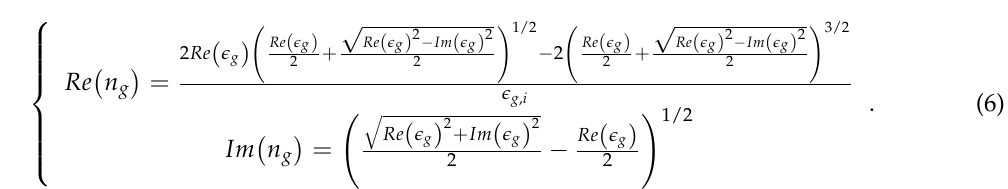
Figure 1c maps the numerically calculated results of the complex permittivity and complex refractive index. These results directly indicate the optical dispersion of graphene-based microfiber structures, which was experimentally demonstrated by Yao et al. in 2013 [41].